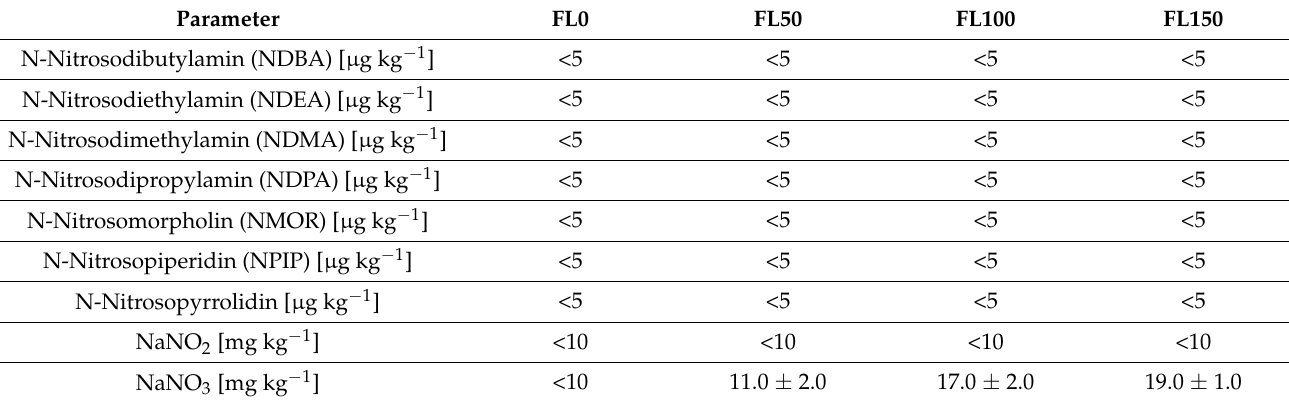
Table 7. Nitrosamine, nitrite and nitrate residues in fermented loins after production.